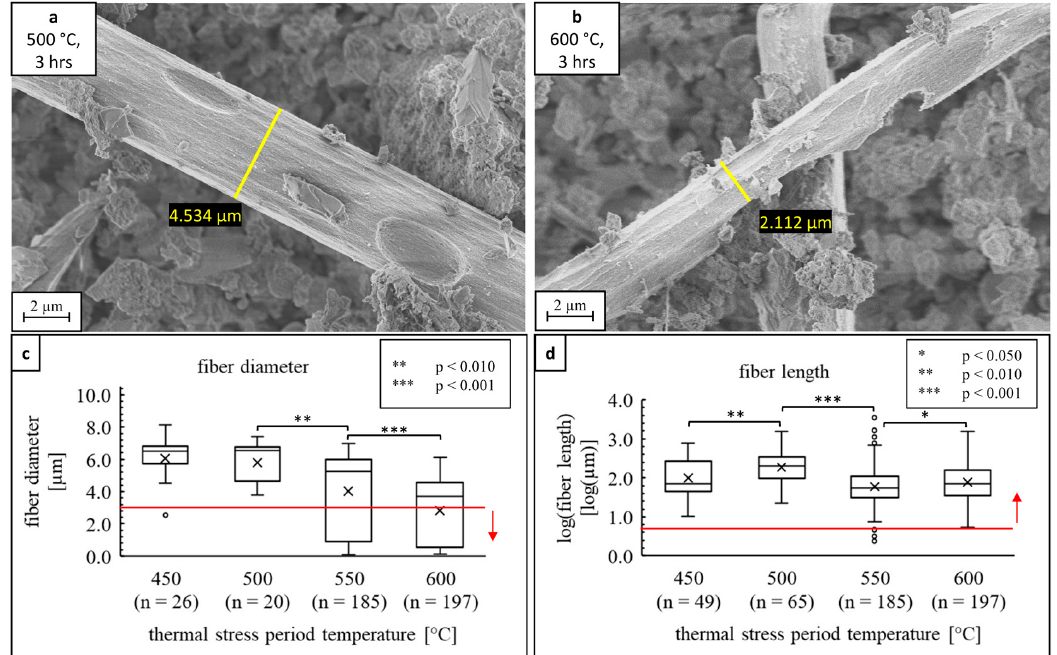
Figure 5. SEM micrographs (5000× magnification). Morphology of fibers in PM 10 formed during dry-cutting of C 3 exposed to 500 ( a ) and 600 °C (( b ), air atmosphere, 3 h). Pitting processes start to occur at 500 °C, leading to decreasing fiber diameters ( c ), while fiber lengths ( d ) show no clear trend. The speciation for harmful fibers according to the WHO definition (length >5 µm, diameter <3 µm) is indicated by a red line and arrow.